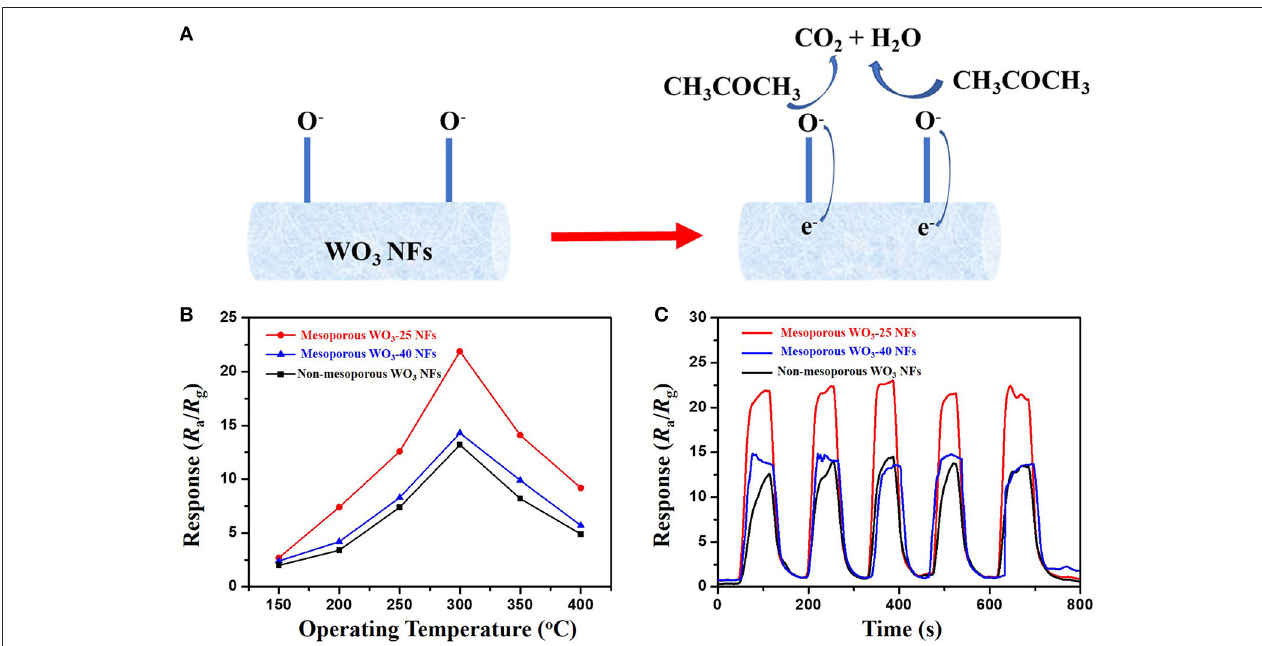
FIGURE 4 | (A) sensing mechanism of WO 3 NFs toward acetone. (B) responses of the mesoporous and non-mesoporous WO 3 NFs sensor to 50 ppm acetone at different operating temperatures (150–400 ◦ C). (C) repeating response and recovery curve of the mesoporous and non-mesoporous WO 3 NFs to 50 ppm acetone.